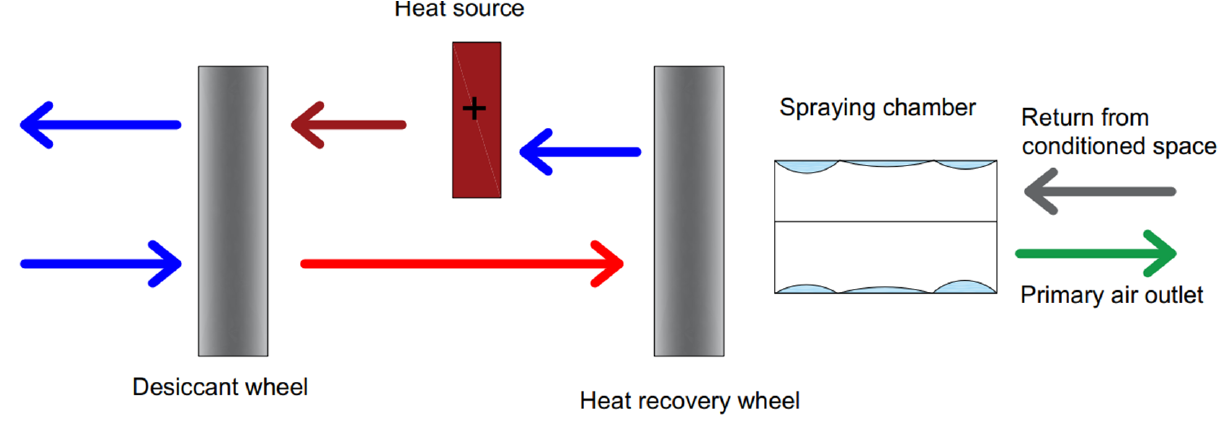
Figure 8. Diagram of a typical solar DAC system [55].